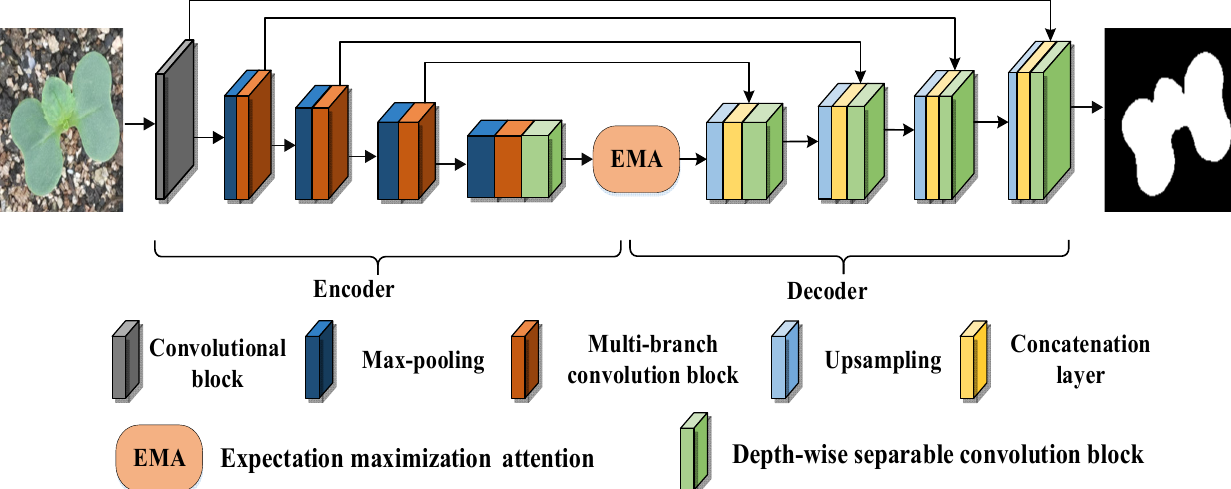
Figure 3. The architecture of the proposed segmentation model.